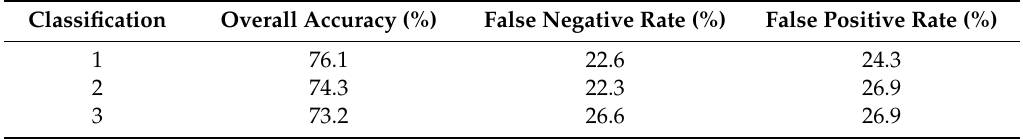
Table 5. Accuracy rates achieved as a result of varying input variables in classifications 1, 2 and